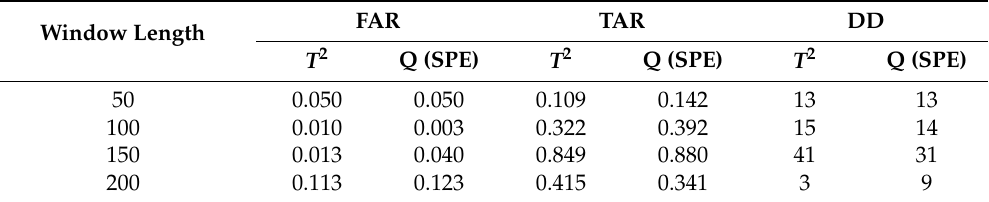
Table 4. Monitoring results on simulated dataset using Method